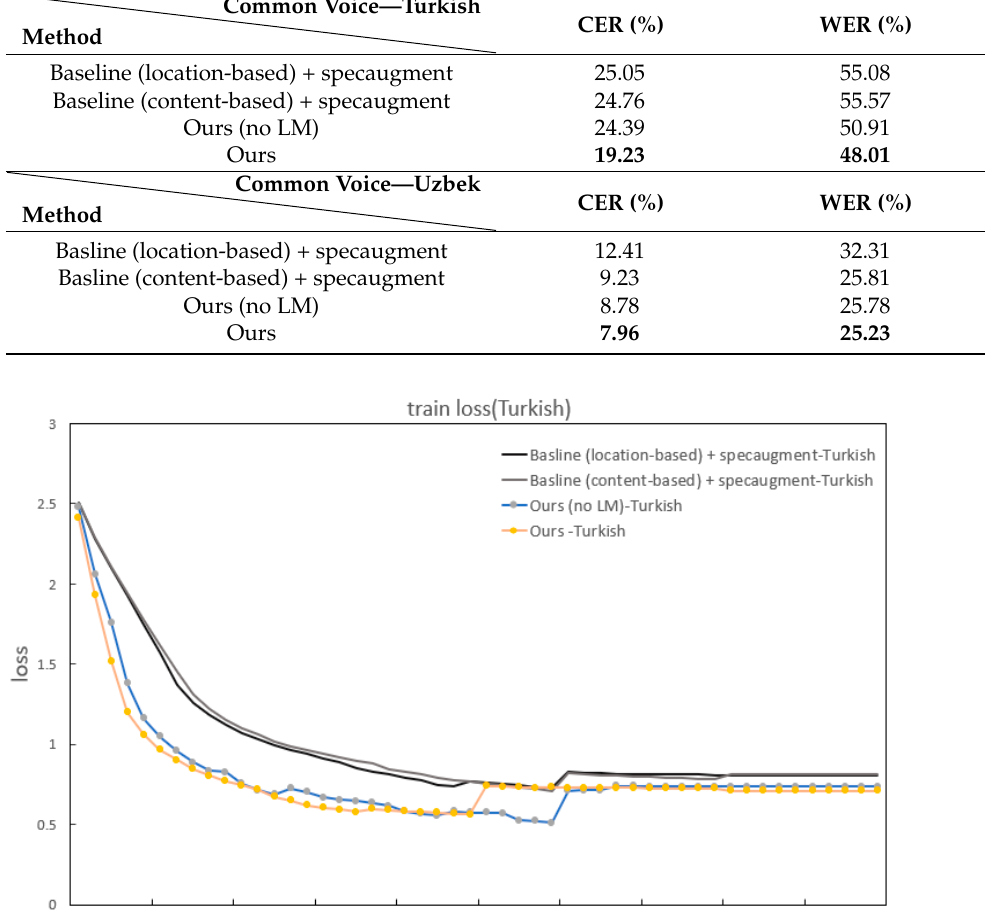
Table 4. The performances comparison of the other two datasets (Turkish and Uzbek) using different methods. Our experimental results are highlighted in bold.